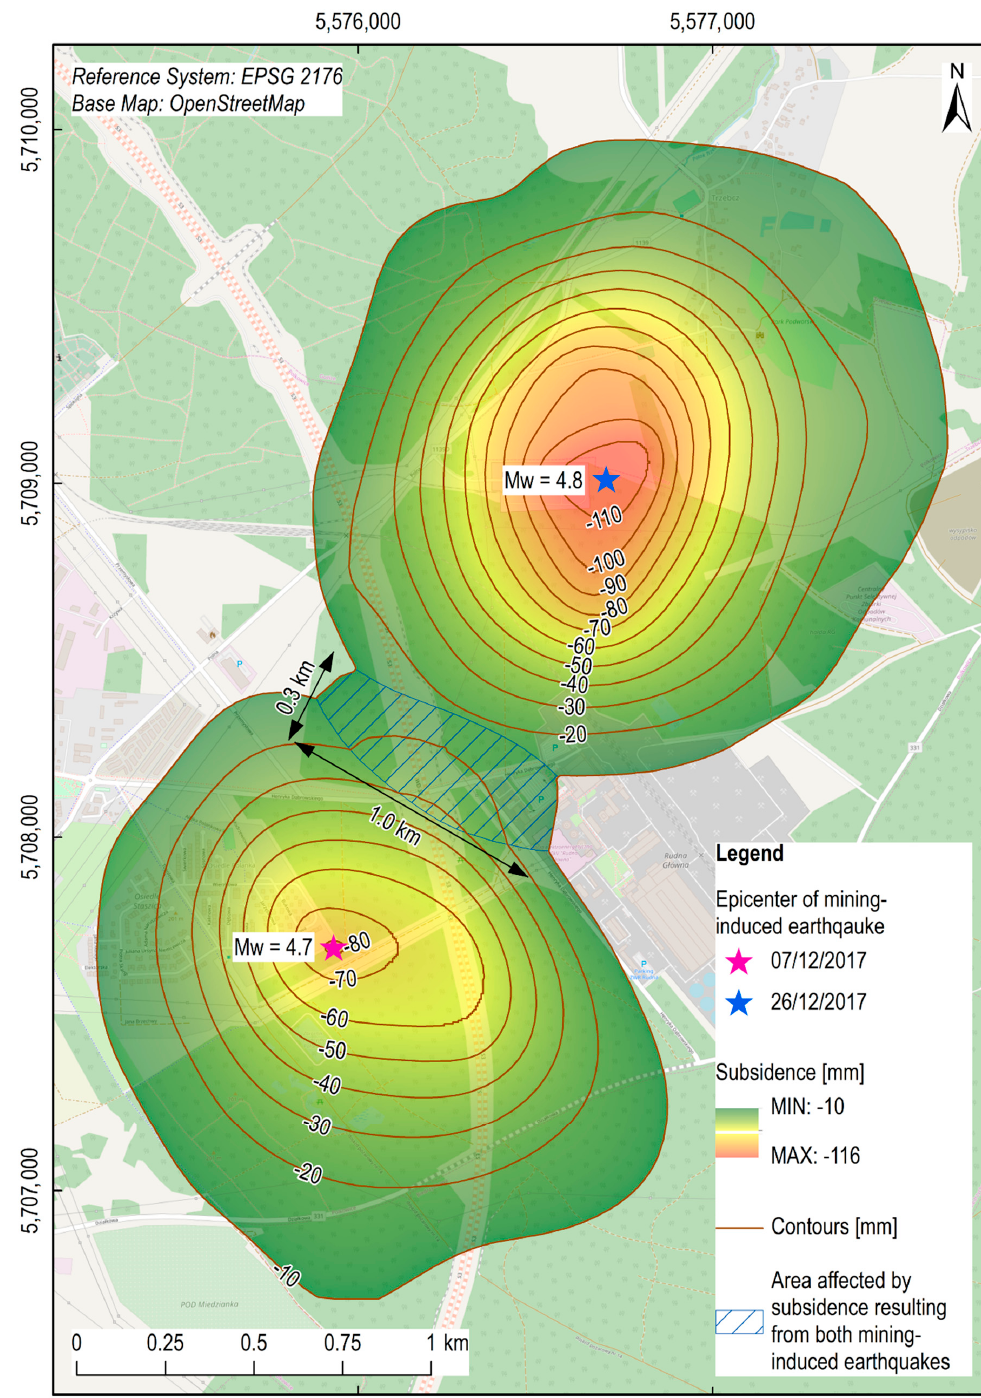
Figure 8. Final subsidence bowls caused by mining-induced earthquakes in the period between 5th December 2017–7th January 2018. December 2017–7th January